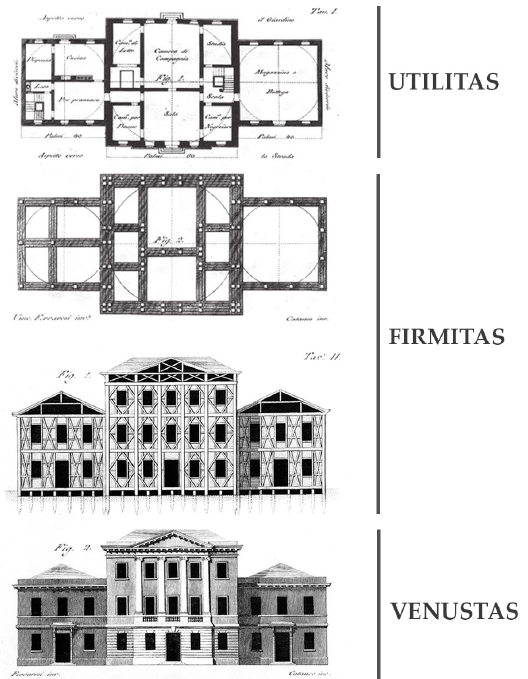
Figure 1. Exempli fi cation of the Vitruvian triad: fi rmitas, utilitas, venustas